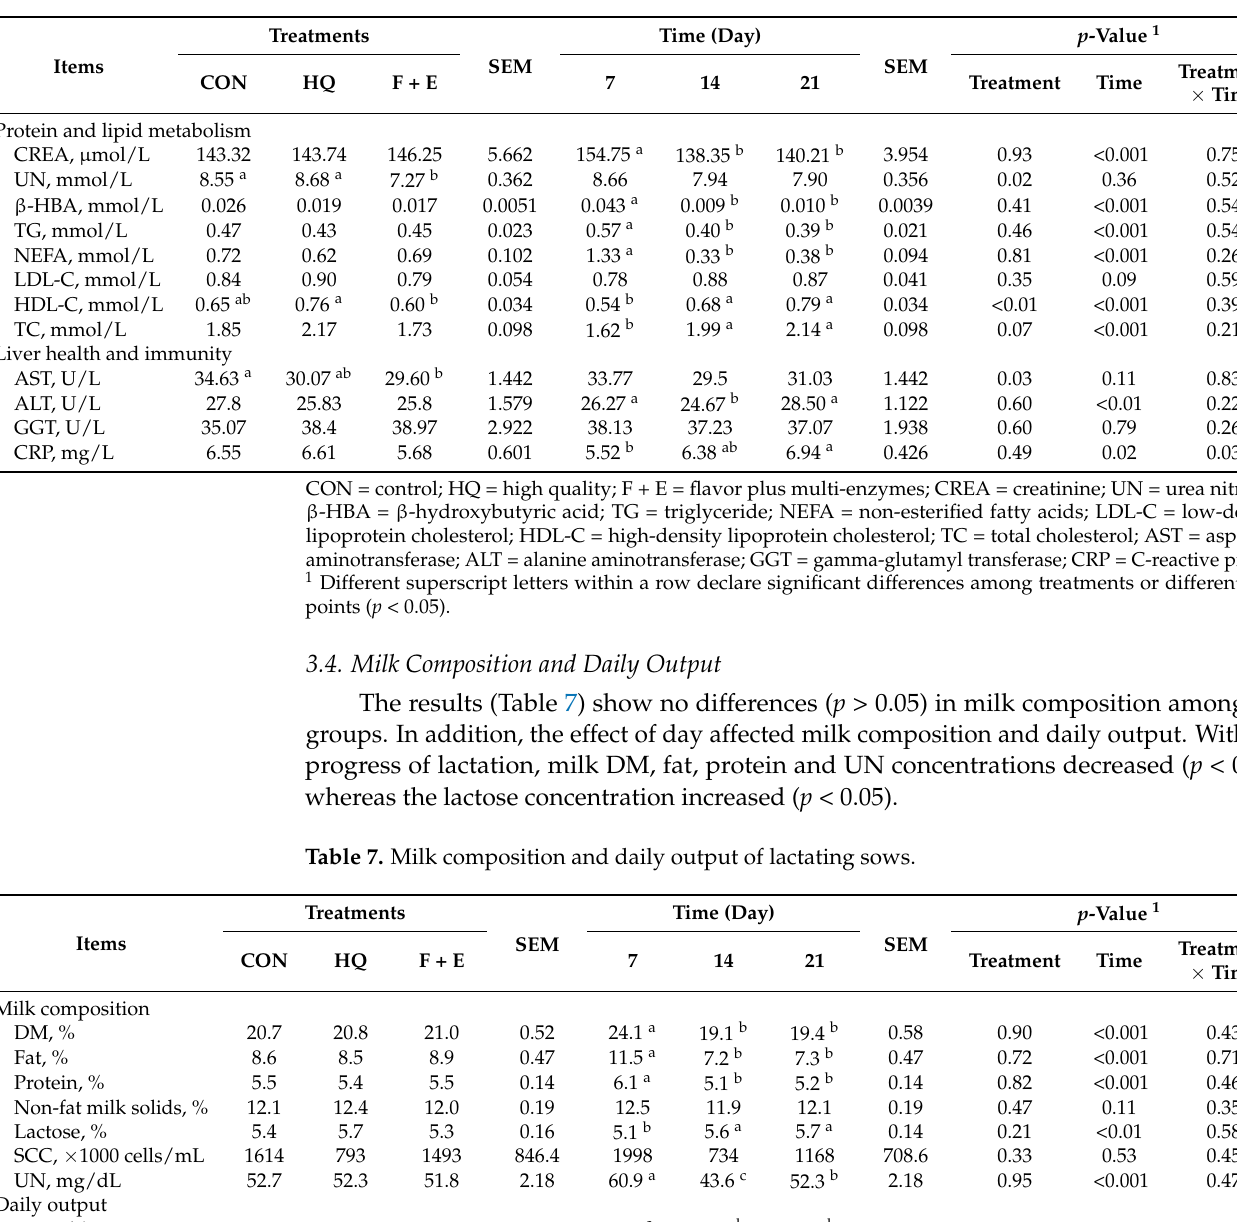
Table 6. Serum biochemical indices related to protein and lipid metabolism, liver health and immunity of lactating sows.